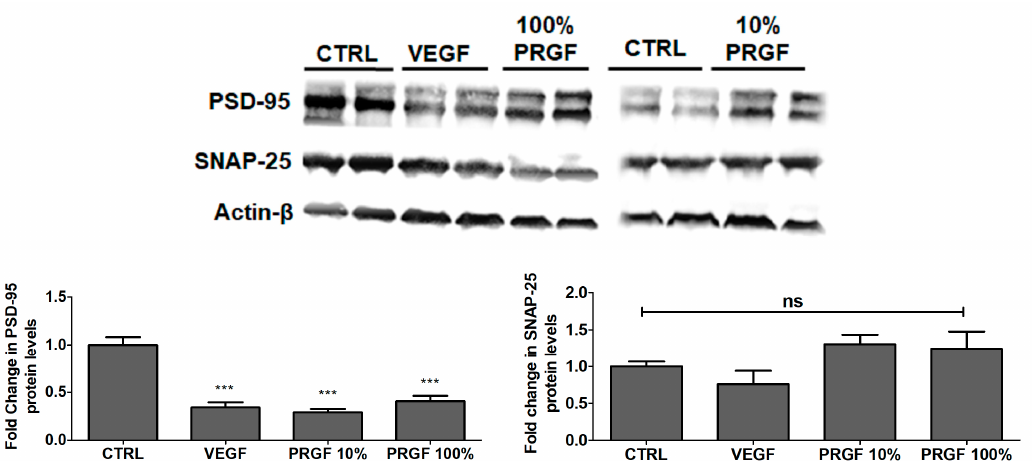
Figure 7. Effect of VEGF (100 pg/mL) and PRGF (10 and 100%) treatments on synaptic markers in 5xFAD mice brains. Representative blots and densitometry analysis of PSD-95 and SNAP-25 in mice brain homogenates. Data are presented as mean ± SEM ( n = 7 mice/ group). *** p < 0.001 compared to control (CTRL) group; ns is not significant.